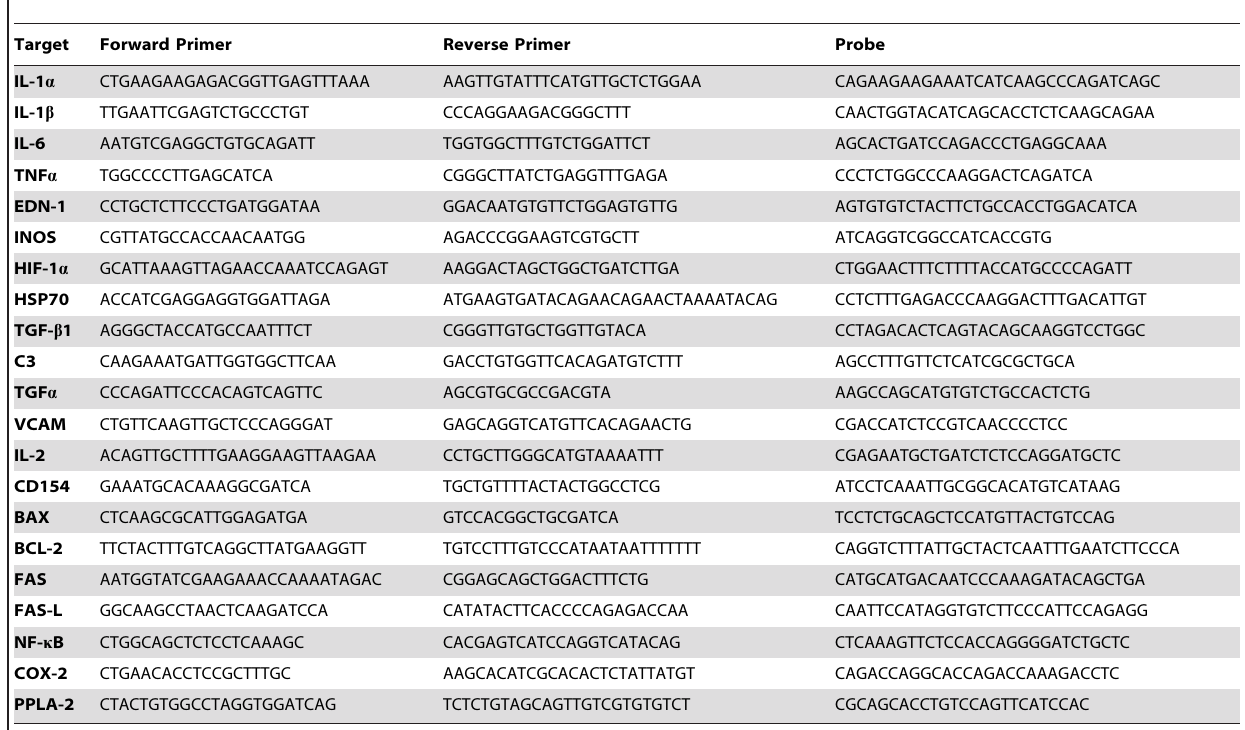
Table 1. RT-PCR targets with primer and probe